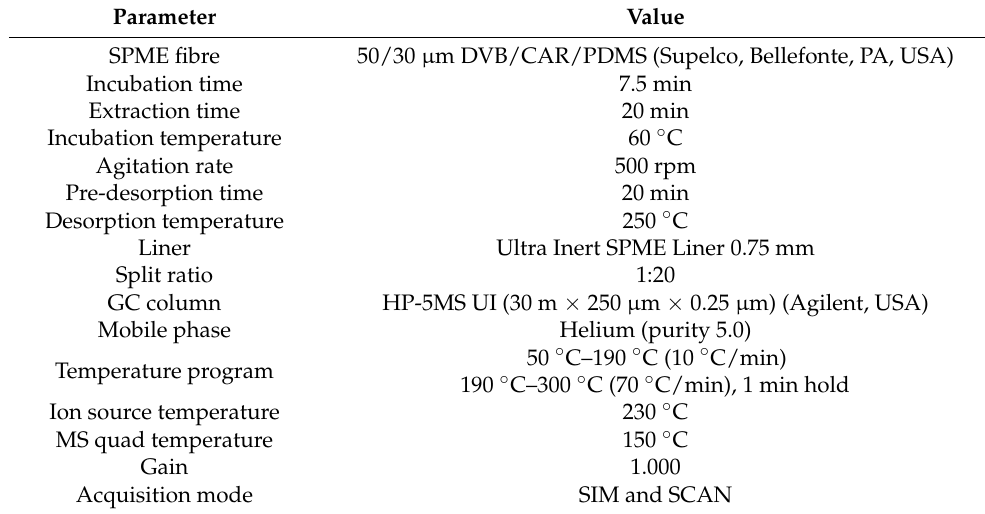
Table 1. Operating conditions for HS-SPME-GS-MS determinations of hop volatiles in